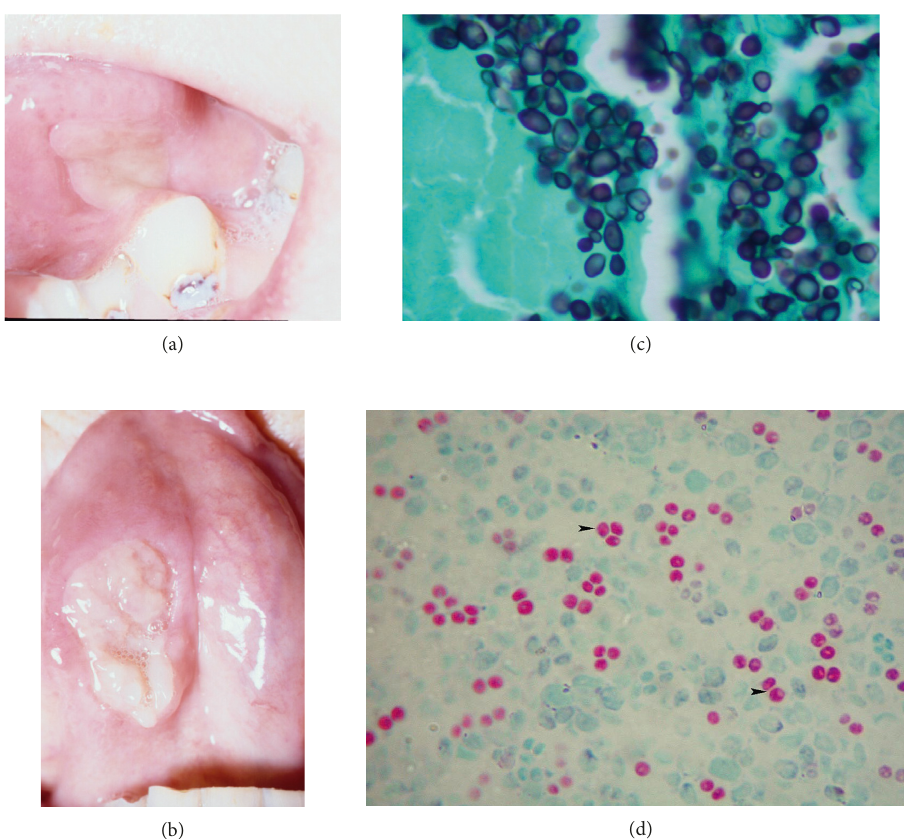
Figure 1: (a, b) Lesions on the tongue (4 × 2 cm and 3 × 2 cm) with slightly rolled and raised edges. (c) High-power view of a Gomori methenamine silver stain (GMS). Biopsy from ulcerated vocal cord lesion demonstrates spherical to oval yeast cells, some of which are budding. (d) High-power view of a Kinyoun stain. Round ascospores (arrowhead) inside the asci that are characteristic of S. cerevisiae